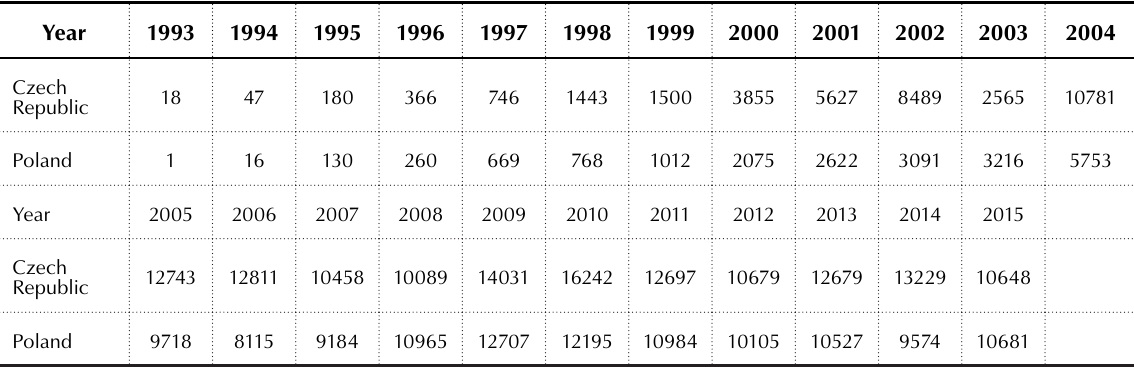
Table 2. The number of the registered certificates by